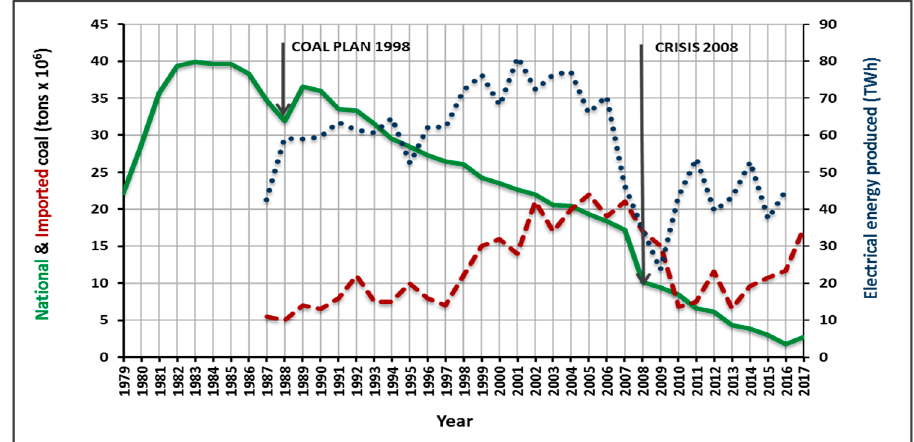
Figure 1. Historical consumption of coal for thermoelectric energy generation in Spain